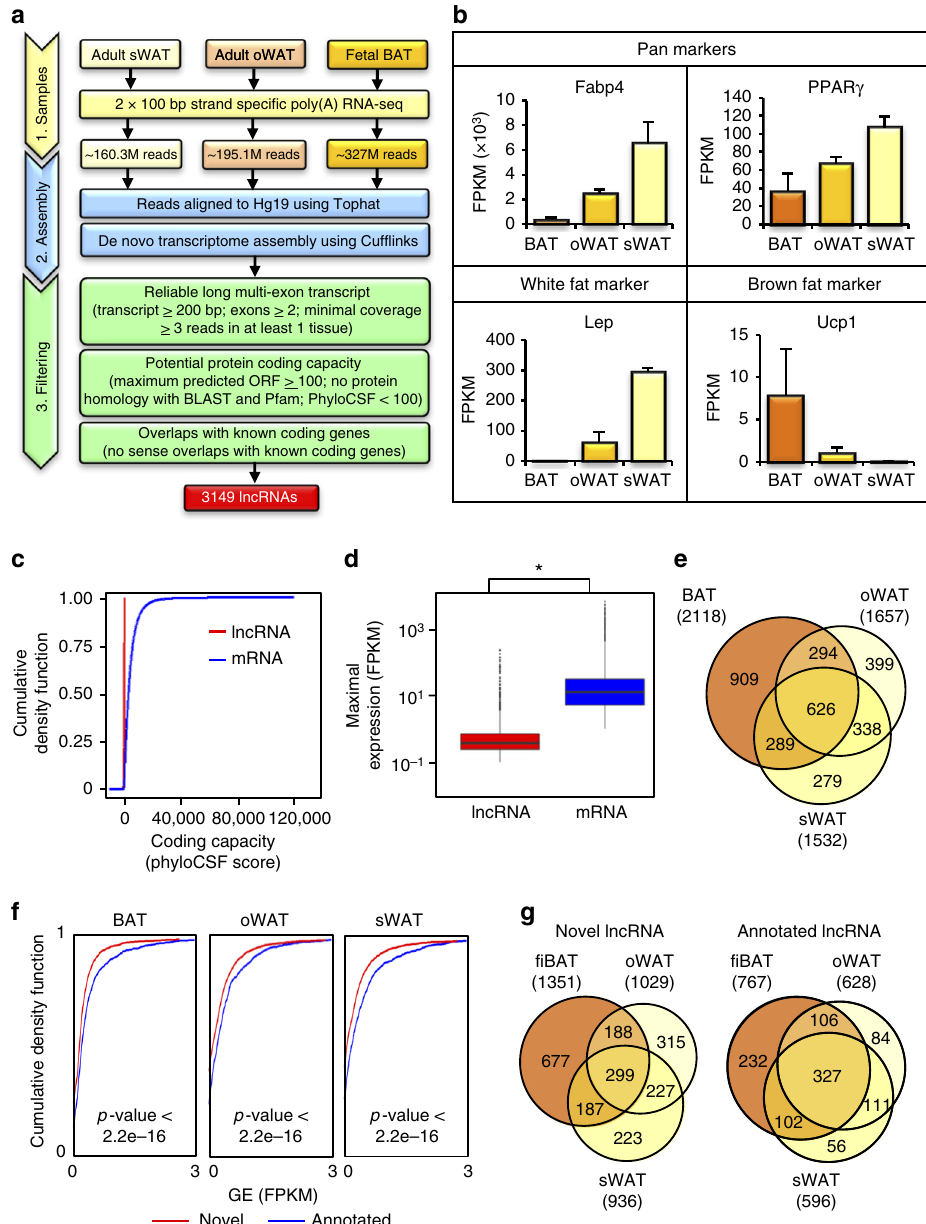
Fig. 1 Generation and characterization of human adipose lncRNA. a Bioinformatics pipeline for human adipose lncRNA discovery pipeline. See “ Material and methods ” for details. b RNA-seq gene expression for pan markers (Fabp4 and Ppar γ ), white fat-speci fi c marker (Leptin), and brown fat-speci fi c marker (Ucp1). Error bars represent mean ± SEM. n = 3/4. c Coding potential of lncRNAs and mRNAs represented by PhyloCSF score. d Boxplots of the maximal expression distributions for adipose-expressed lncRNA (FPKM > 0.1) and mRNA (FPKM > 1). Mann – Whitney U -test p -value < 2.2e-16. * denotes p-value < 0.05. e Overlaps of detectable lncRNAs between fi BAT, sWAT, and oWAT (FPKM > 0.1 in at least one of the three samples). f Cumulative density function of gene expressions for novel and annotated lncRNAs based on their abundance in BAT (left panel), oWAT (center panel), and sWAT (right panel). Novel lncRNAs exhibit signi fi cant lower expression than annotated ones in all three tissues. g Overlaps of detectable lncRNAs between fi BAT, oWAT, and sWAT (FPKM > 0.1 in at least one of the three samples). LncRNAs are classi fi ed by novel (left panel) and annotated (right panel)